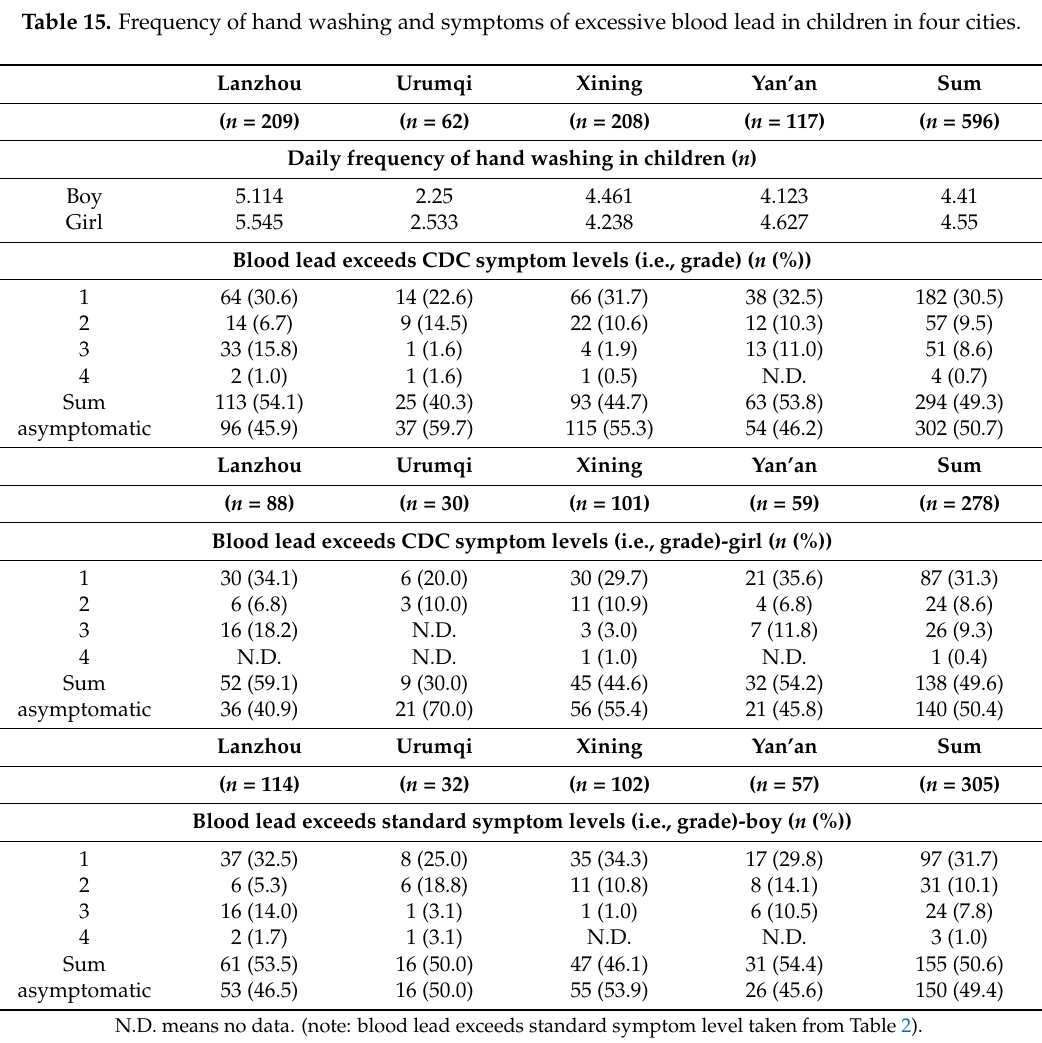
Table 15. Frequency of hand washing and symptoms of excessive blood lead in children in four